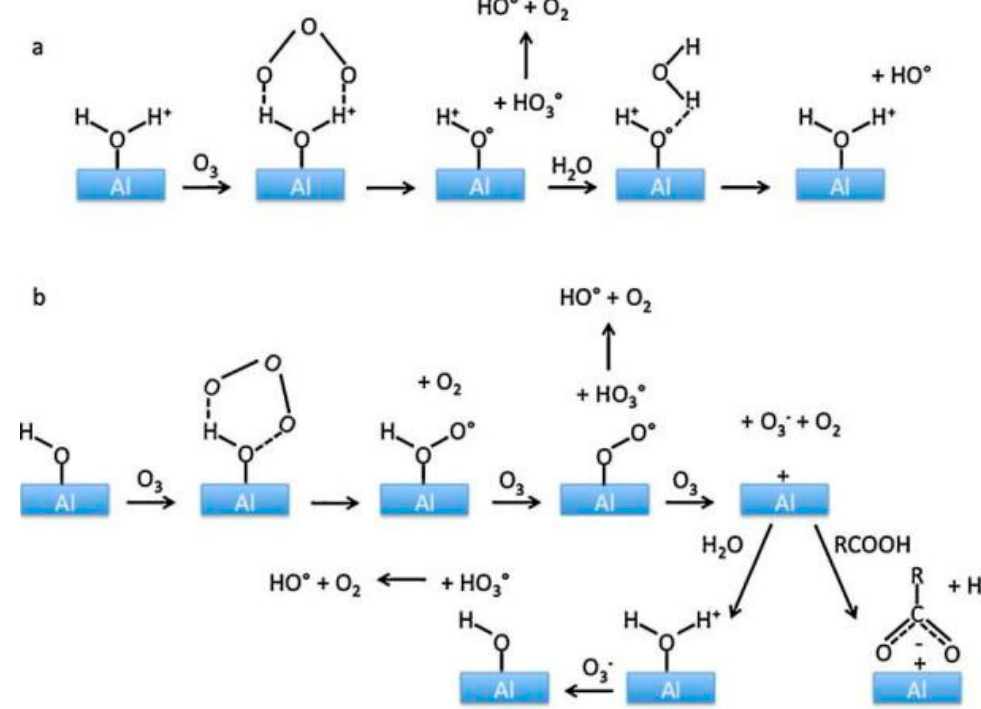
Figure 5. Expected interaction of O 3 with ( a ) acid and ( b ) basic sites of γ -Al 2 O 3 . ( b ) Hypothesis for adsorption mechanism of carboxylic acids with the basic sites of γ -Al 2 O 3 during ozonation.